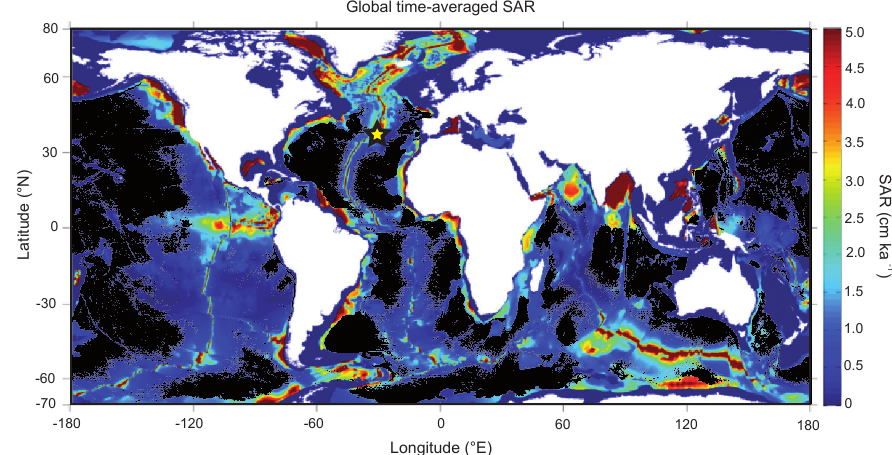
Figure 1. Map of time-averaged deep-sea sediment accumulation rates (SARs) adapted from Olson et al. (2016). Note that continental margins are not included in the SAR estimate. Superimposed on this map in black is an approximate indication of seafloor areas under the calcite compensation depth, estimated using a global water depth of 4500m derived from global bathymetry (General Bathymetric Chart of the Oceans, 2015). The location of core T86-10P (37 ◦ 8.13 (cid:48) N, 29 ◦ 59.15 (cid:48) W; 2610mb.s.l.) is indicated by a yellow